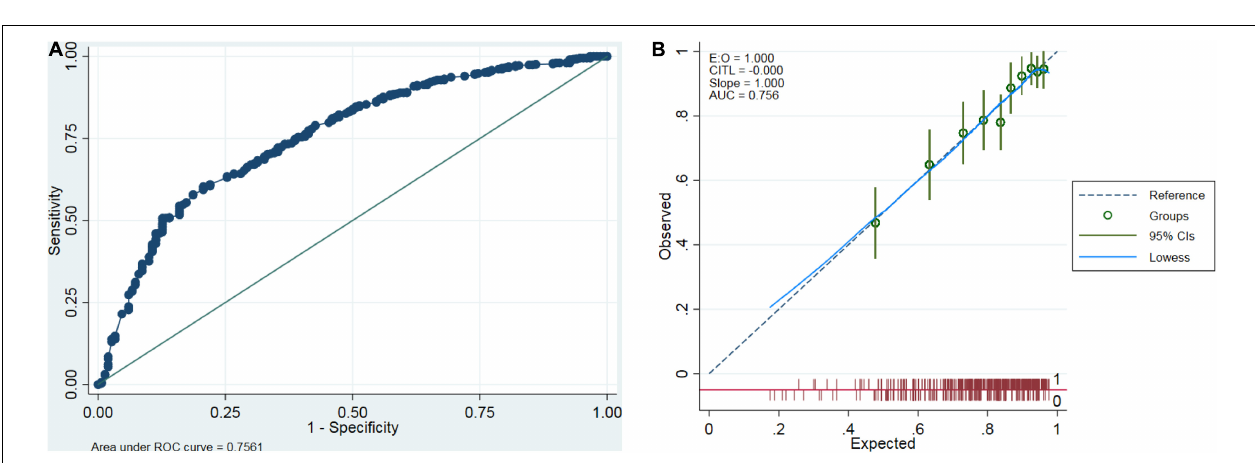
FIGURE 3 | Internal validation of the prediction model. Discrimination was assessed by the receiver operating characteristic (ROC) curve (A) , and calibration was performed by the calibration curve (B) in the entire training dataset.